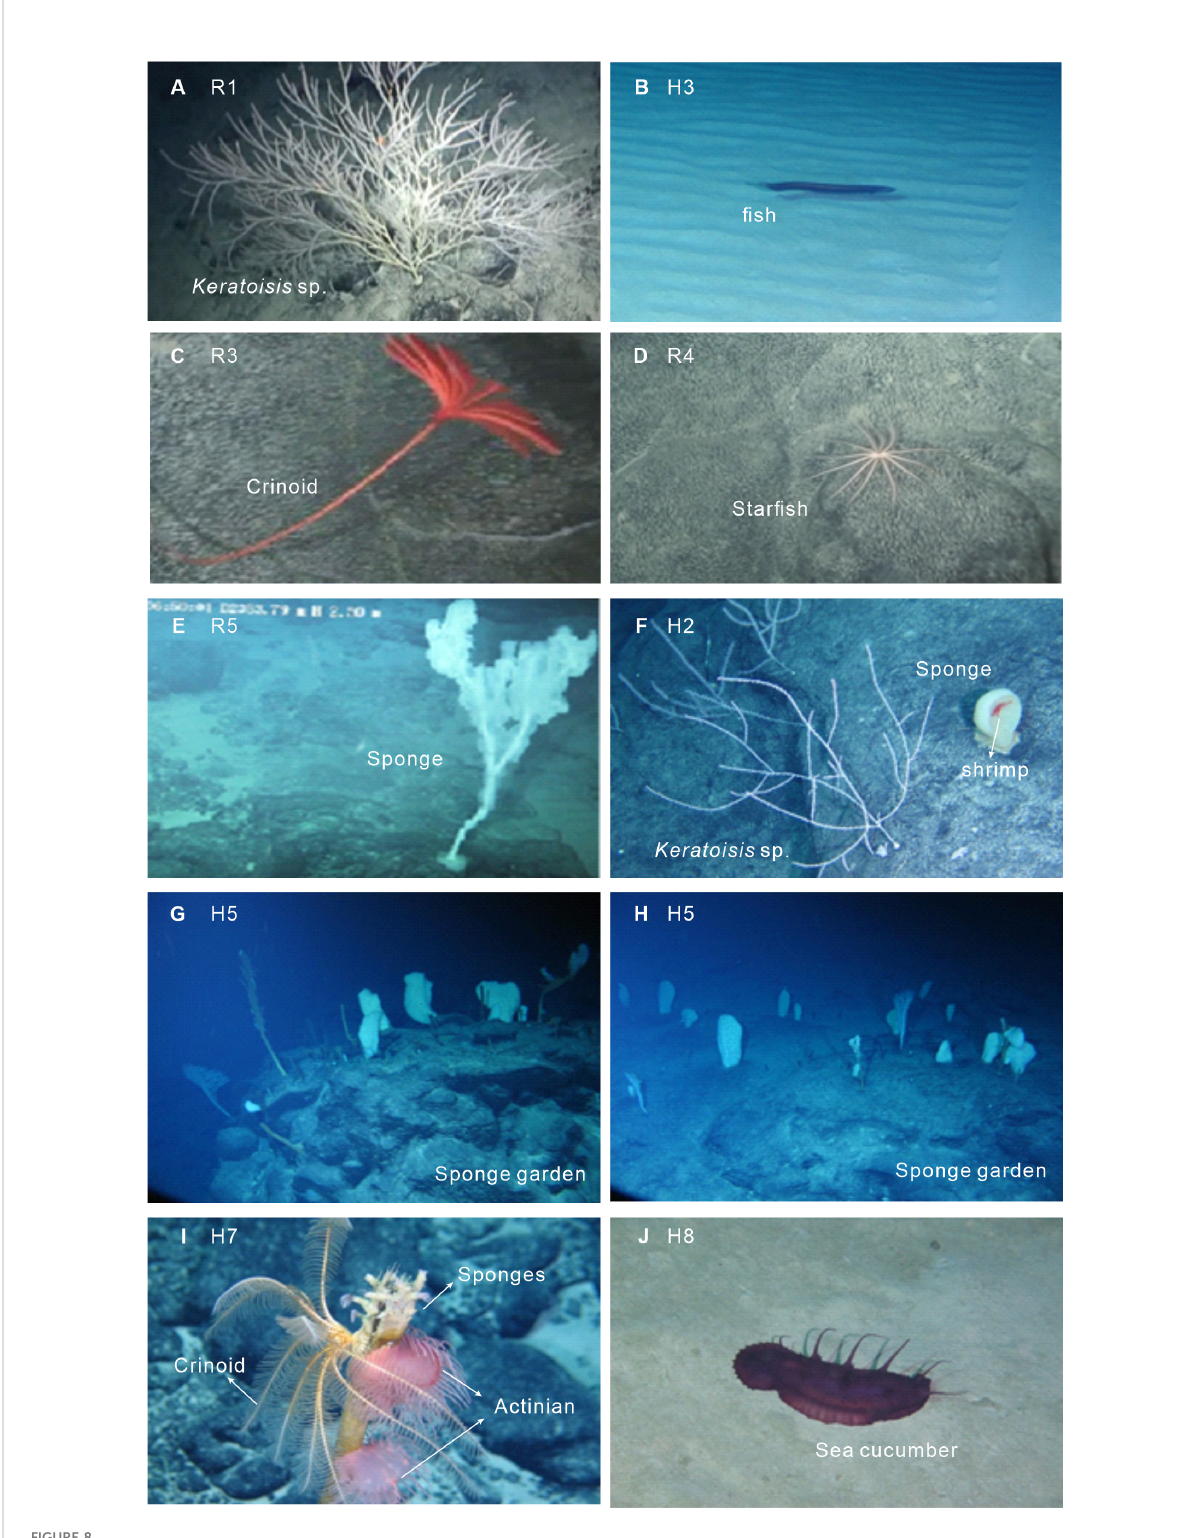
FIGURE 8 Still images of the megafauna: (A) Keratoisis sp. on rock outcrop highs. (B) Fish on fl at unconsolidated sand. (C) Crinoid on rock outcrop highs. (D) Star fi sh on fl at ridge tops with bedrock. (E) Actinian on crevices, narrow gullies with bedrock. (F) Keratoisis sp. and sponge on rock outcrop highs and crevices, narrow gullies. (G, H) Sponge garden on rock outcrop highs. (I) Two actinians and a crinoid attached to the sponge stem on rock outcrop highs. (J) Sea cucumber on broad slopes with unconsolidated